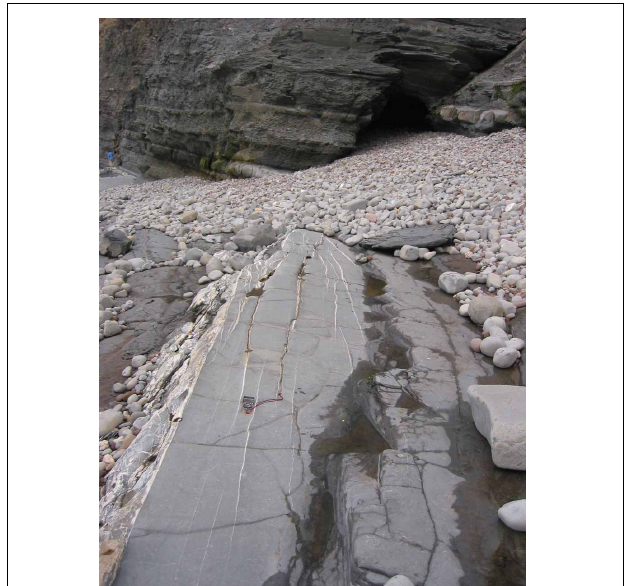
FIGURE 8 | View along strike of a normal fault at Kilve, Somerset coast, Southwest England (cf. Philipp, 2012). There is a dense network of calcite veins running subparallel to the fault plane. The veins extend for a distance of only a few meters away from the fault plane into the damage zone. For the veins in the foreground that are continuous non-restrictive, and undeformed extension fractures and for which both ends are visible in the outcrop, the outcrop length/aperture (thickness) ratios can be measured, so that the fluid overpressure at the time of hydrofracture formation (cf. Figure 9 ) can be estimated using Equation (5). View east; see the compass for scale.